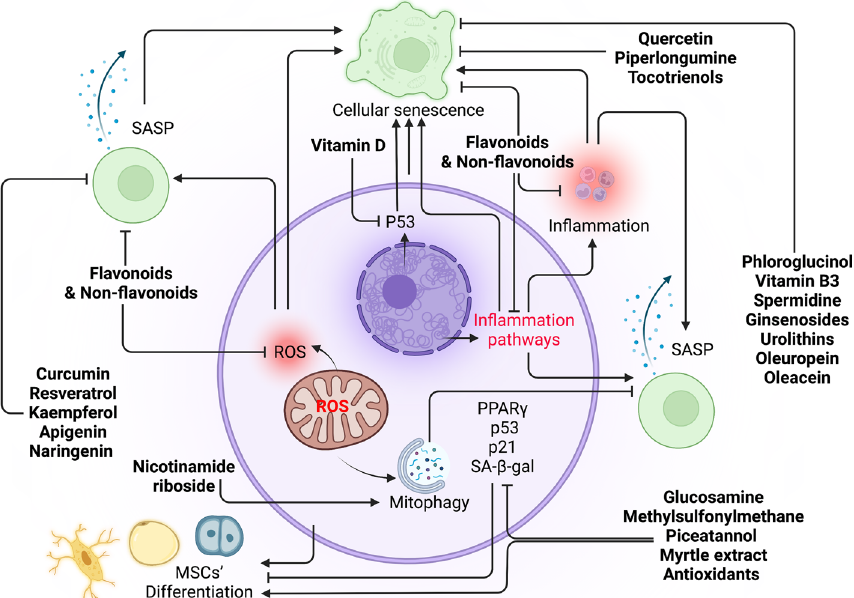
Fig. 7 Nutraceutical intervention as a strategy to combat cellular senescence. Flavonoids, nonflavonoids, and other nutraceuticals compromise cellular senescence through regulating ROS, inflammation, SASP, p53, p21, and PPARγ. Activate, inhibit, nutraceuticals (bold)